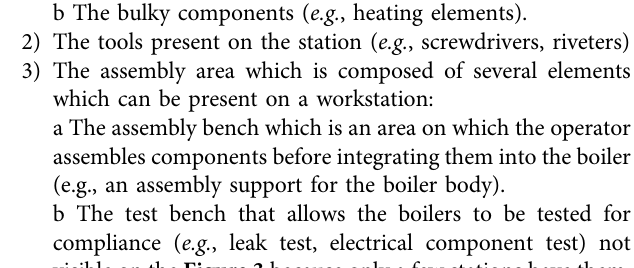
Frontiers in Virtual Reality |